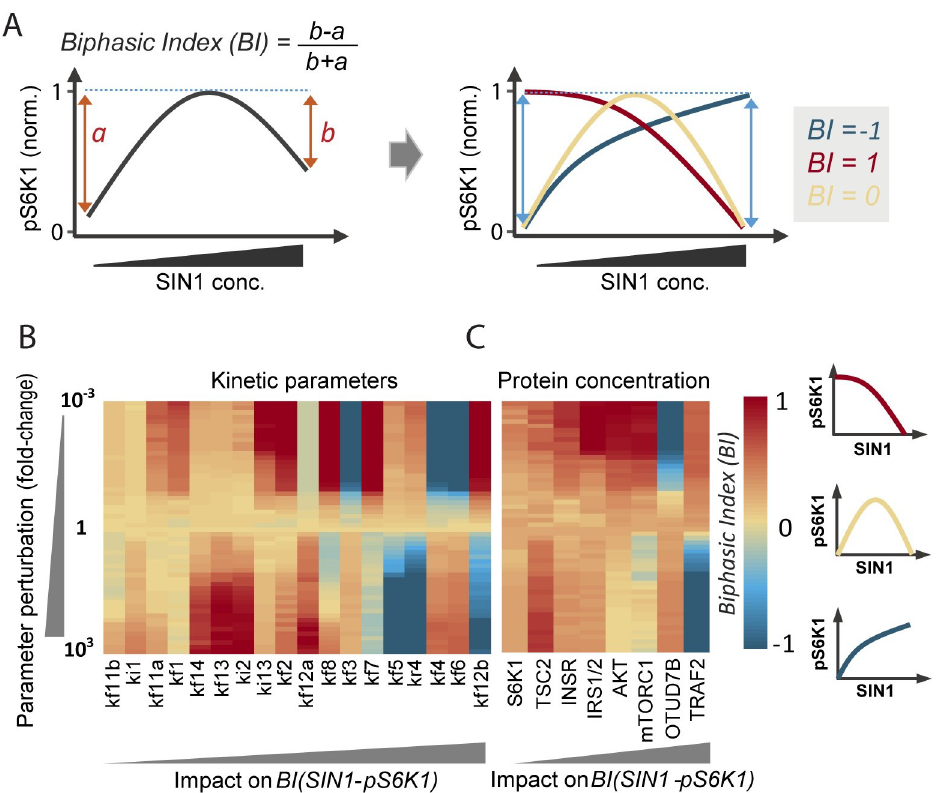
Fig 6. Deciphering the molecular players that govern the SIN1-mTORC1 biphasic dependency. (A) Derivation of a quantitative Biphasic Index (BI) measuring the biphasicness of pS6K1 response curve to SIN1 perturbation. To generate the SIN1-pS6K1response curve for a specified parameter set, we gradually increase SIN1 expression within the range = [0.01, 1000] folds of the nominal value and we simulated the corresponding pS6K1 level and obtained its steady state value. The response curve is then normalized to its peak (max) value. BI ranges between -1 and 1: BI = -1 or 1 indicate a strictly monotonic increasing (blue) and decreasing response curve (red), respectively; while -1 < BI < 1 indicates a biphasic pattern that is more pronounced as BI is closer to 0 (yellow). (B-C) Impact of perturbation of model kinetic parameters (B) or protein concentrations (C) on the BI of the SIN1-mTORC1 response curve. The kinetic parameters were perturbed one by one within wide ranges (1000 folds up/down of nominal values), and the impact on the BI were computed. For the analysis all the best-fitted parameter sets were used for the parameter perturbation analysis and the average results across these multiple parameter sets were calculated. The parameters/ proteins are ranked as having minimum (left) to maximum (right) effect on variation of BI